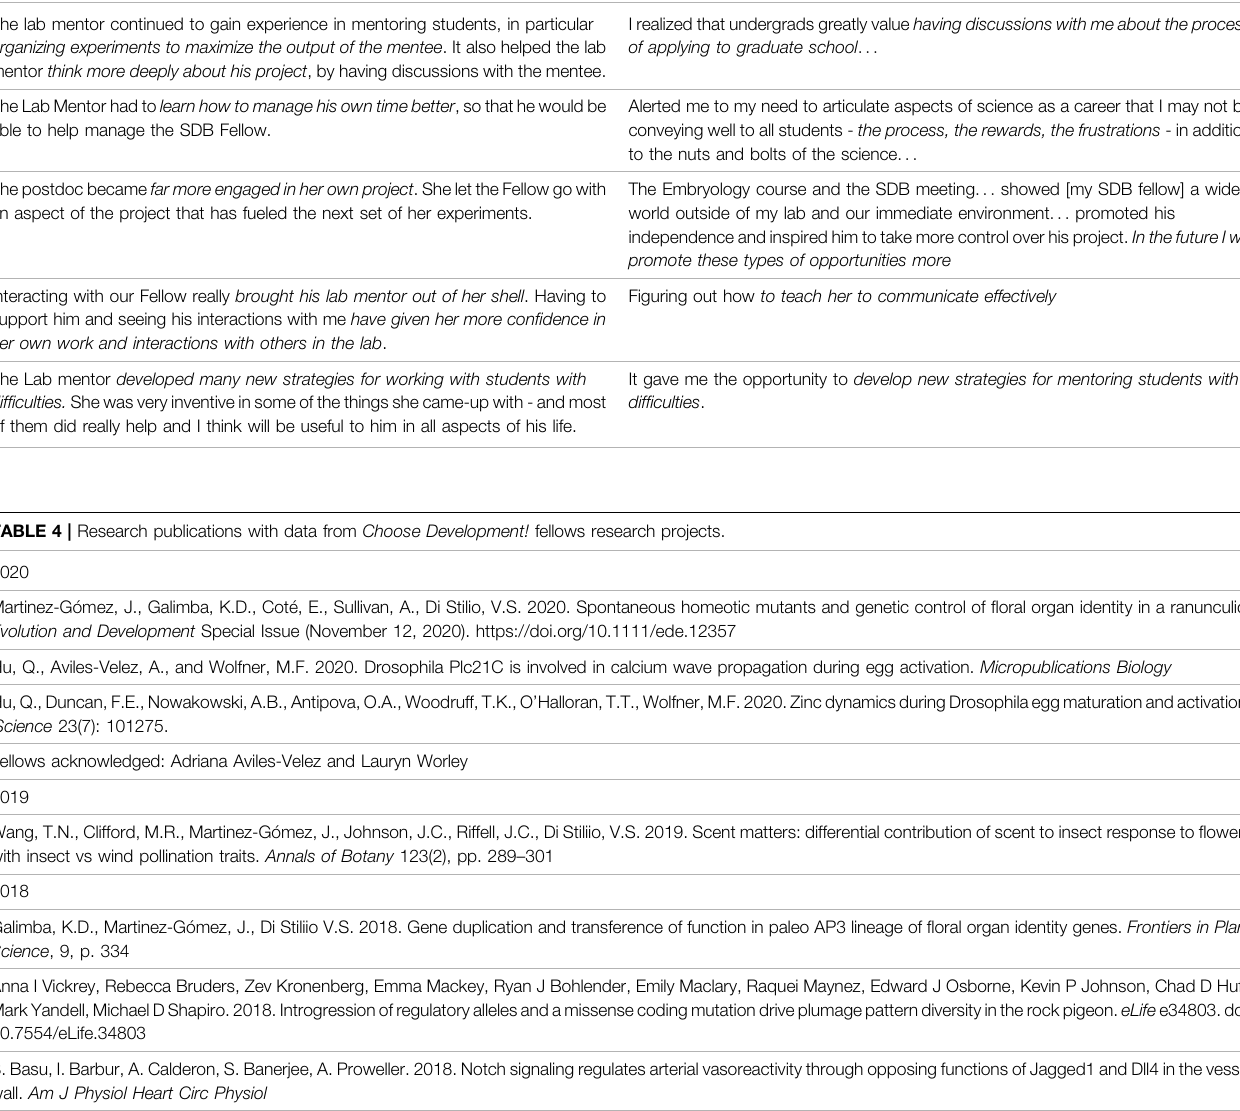
TABLE 3 | Impact of Choose Development! program on academic and lab mentors — some insights. Lab mentors